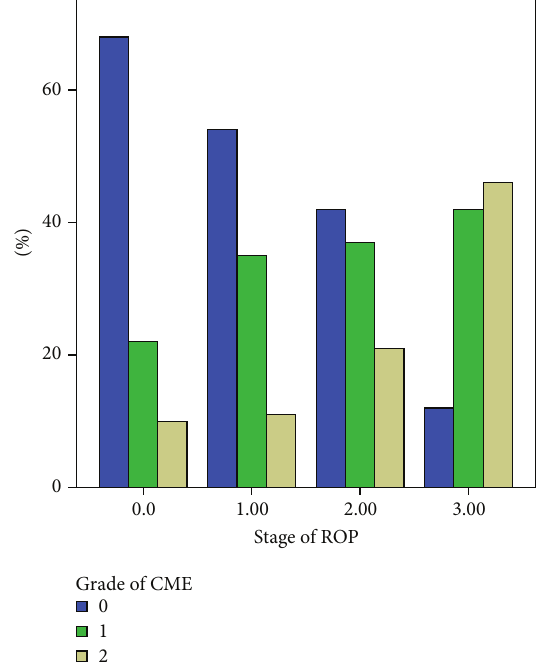
Figure 3: Comparisons of cystoid macular edema grading in eyes accordingtostageofROP.(ROP:retinopathyofprematurity, 𝑃 :0.001 chi-square